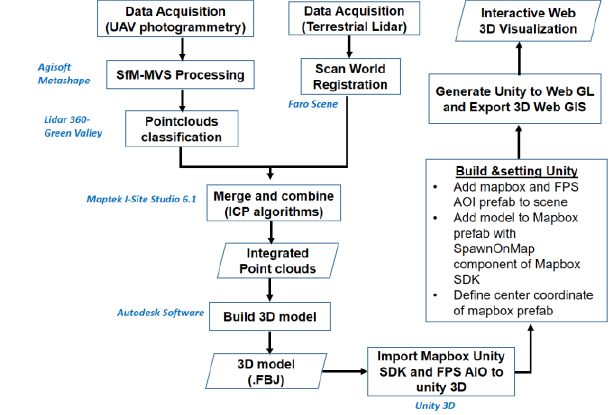
Figure 6. Workflows for data integration and 3D